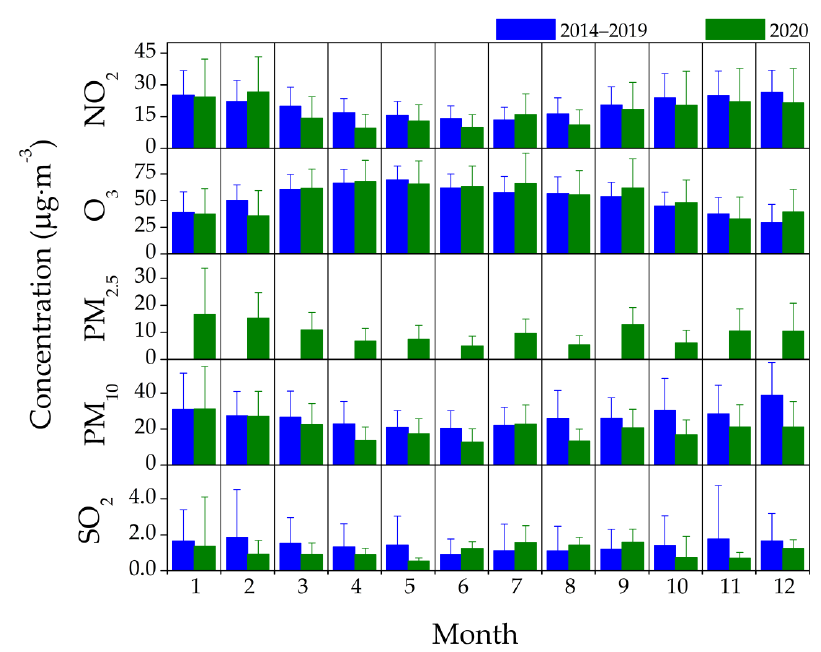
Figure 7. Mean monthly levels of NO 2 , O 3 , PM 2.5 (only for 2020), PM 10 and SO 2 during the periods of 2014–2019 and 2020 in the studied urban-industrial